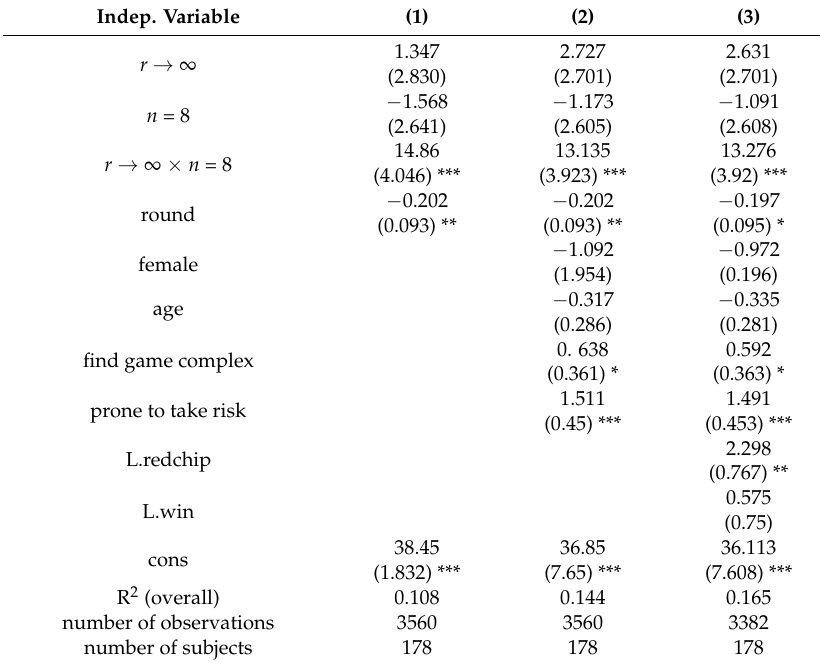
Table 4. Panel regressions of the bets per round and per